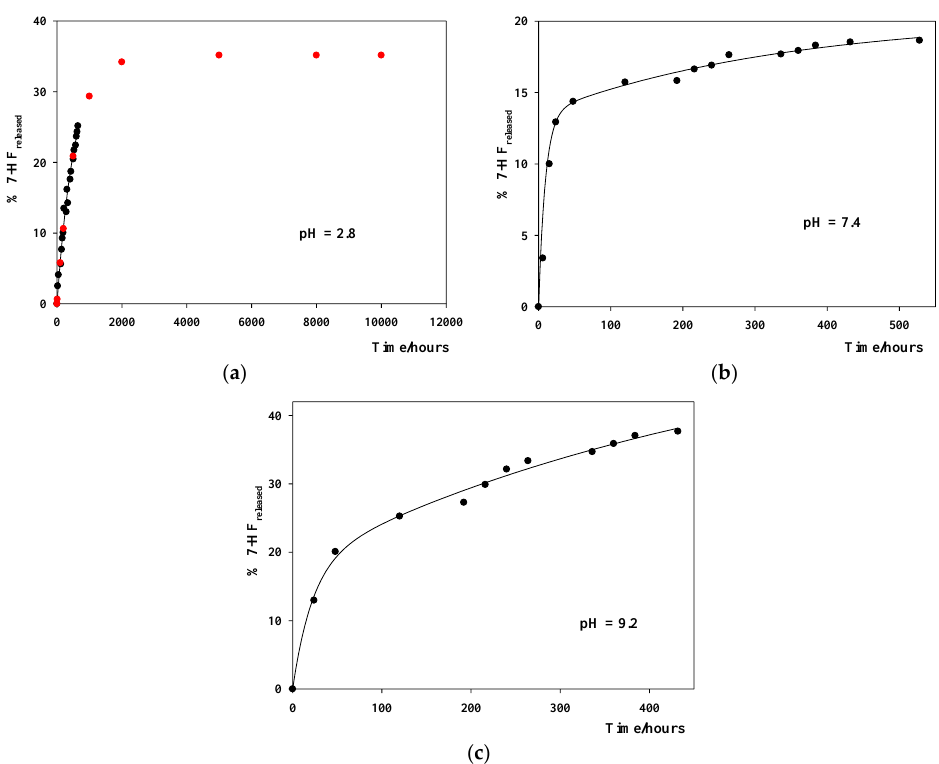
Figure 6. In vitro release profiles of 7-HF from 7-HF/SWCNT complexes at different pHs. ( a ) pH = 2.0; ( b ) pH = 7.4; ( c ) pH = 9.2. Solid lines correspond to the fitting of the experimental data using Equation (8), for pH = 2.0, and Equations (8) and (9), for pHs 7.4 and 9.2. The red dots are the predicted values for the complete release profile at pH = 2.0. These values were obtained by using Equation (8).